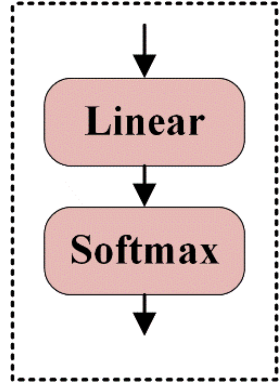
Figure 12. Feature attention layer.